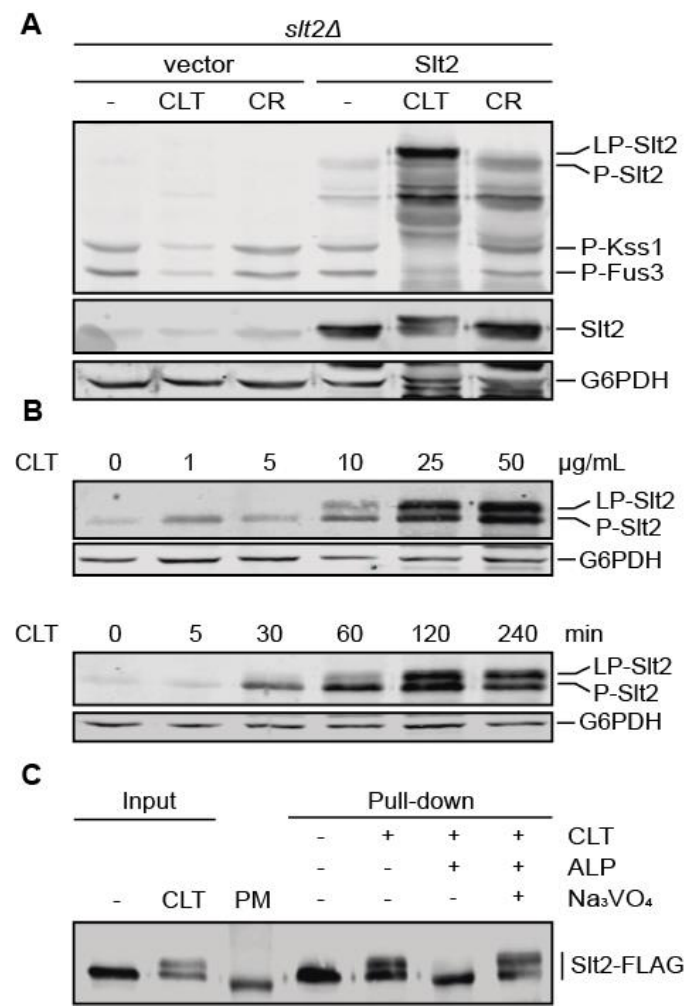
Figure 2. Characterization of Slt2 phosphorylation and LP-Slt2 emergence upon clotrimazole treat- ment. ( A ) Western blotting analysis of extracts of BY4741 slt2Δ cells transformed with either the empty vector pRS316 or pRS316- SLT2 and cultured with 50 µ g/mL of CLT, 30 µ g/mL of CR, or without treatment ( − ) for 4 h at 24 ◦ C. Dually phosphorylated Slt2, Kss1, and Fus3; Slt2 protein; and G6PDH (as a loading control) were detected with anti-phospho-p44/42, anti-Mpk1, and anti-G6PDH, respectively. ( B ) Western blotting analysis of extracts of BY4741 cells treated with increasing concen- trations of CLT for 4 h (upper panel) and with 50 µ g/mL of CLT for different times (lower panel) at 24 ◦ C. Dually phosphorylated Slt2 and G6PDH were detected as described in ( A ). ( C ) Alkaline phosphatase assay of BY4741 slt2 ∆ cells transformed with p2313 plasmid (Slt2-FLAG) and cultured with (+) or without ( − ) 50 µ g/mL of CLT for 4 h at 24 ◦ C. Immunoprecipitated Slt2-FLAG with anti- FLAG antibodies (pull-down) was treated with (+) or without ( − ) alkaline phosphatase (ALP) from calf intestine in the absence ( − ) or presence (+) of sodium orthovanadate (Na 3 VO 4 ), a phosphatase inhibitor. Cell extracts (input) were also analyzed. Slt2-FLAG was detected with anti-Mpk1 antibody. PM corresponds to the lane loaded with the molecular weight protein marker. Representative blots from three ( A , B ) and two ( C ) independent experiments are